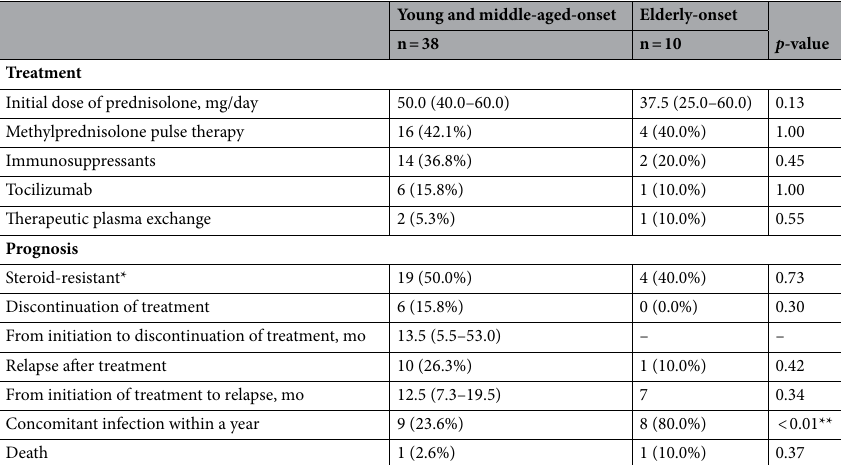
Table 4. Comparison of the treatment and prognosis of the young and middle-aged-onset and elderly-onset groups. Data represent median (interquartile range) or numbers of patients. *Steroid-resistant; impossibility to taper prednisolone to < 0.4 mg/kg/day because of residual disease activity of AOSD. p -value: Fisher exact test for categorical variables and Mann–Whitney U test for continuous variables. **Significant value ( p <